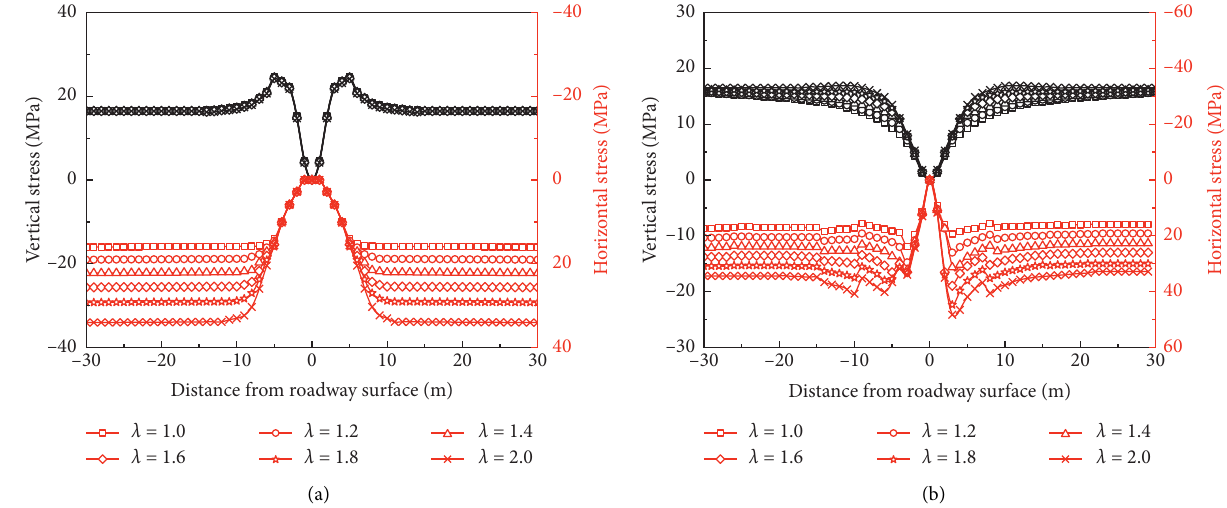
Figure 14: The stress distribution of the roadway. (a) Two sides; (b) roof and